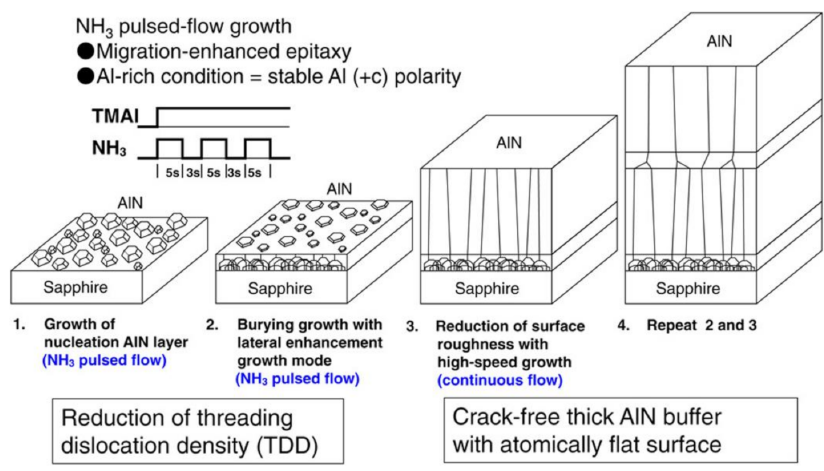
Figure 7. Schematic diagram of morphology and dislocation evolution for MSG-AlN. Reprinted from [43]. Copyright (2014) The Japan Society of Applied